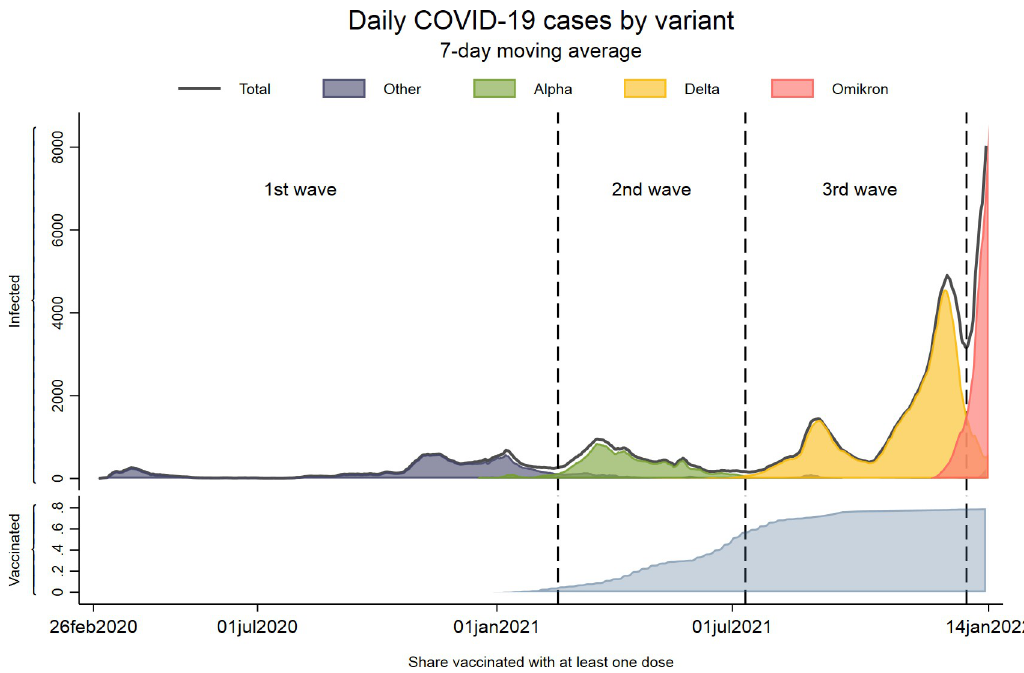
Fig 1. Daily covid-19 cases by variant and share of population vaccinated. The top panel shows the number of persons with a positive PCR-test each day calculated with a 7-day moving average. The solid line in the top panel shows the total numbers of persons infected, and colors represent the share of screened or sequenced tests with each variant the given day. The bottom panel shows the cumulative share of the included population having received at least one dose of SARS-CoV-2 vaccine on the given